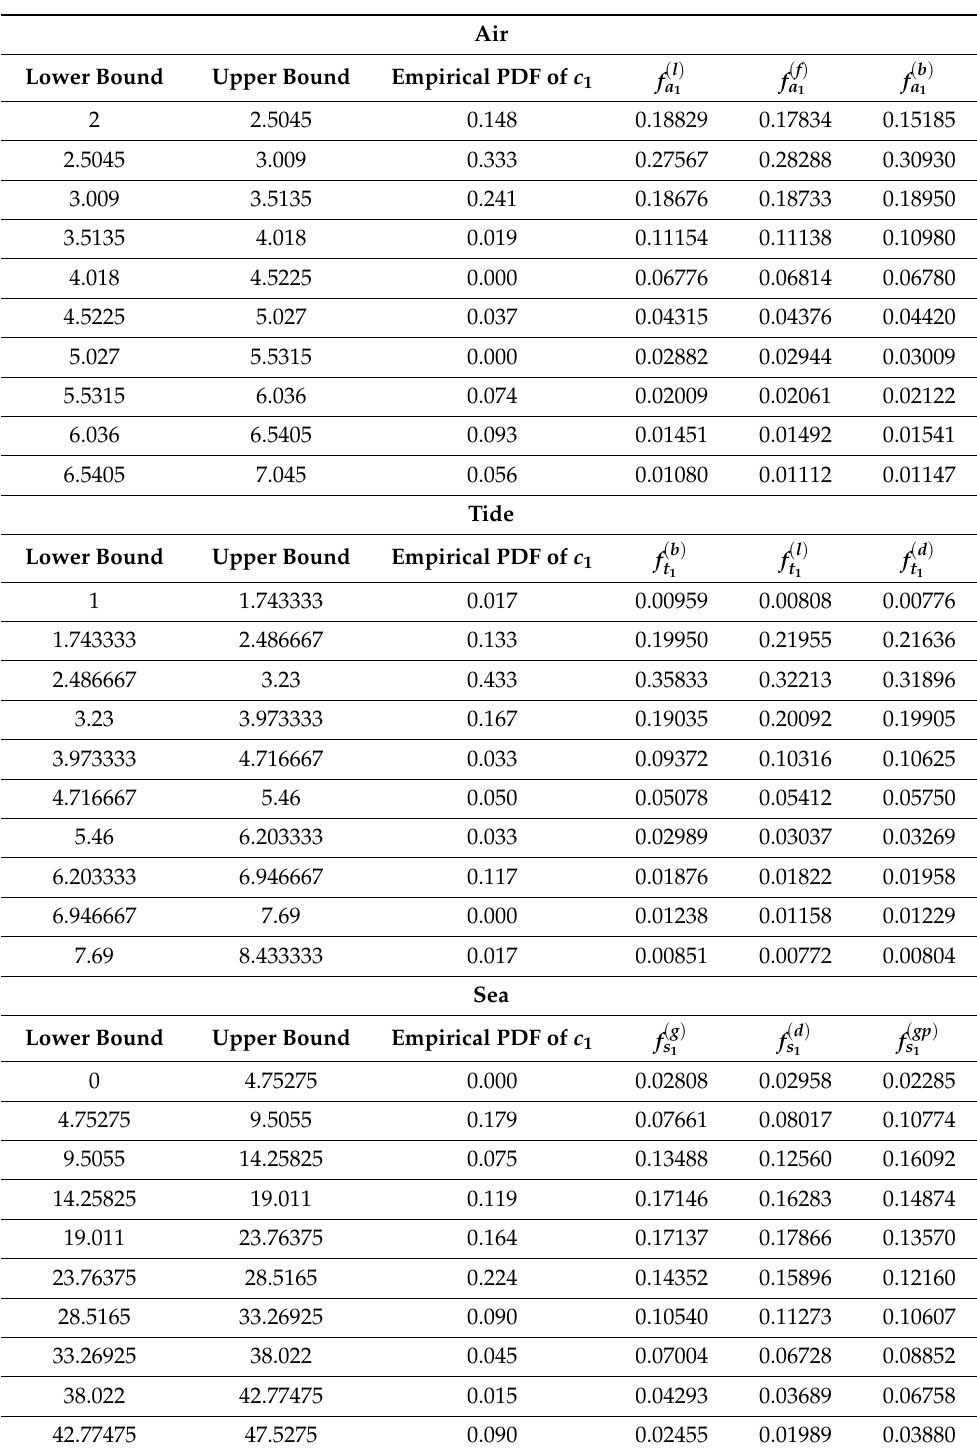
Table 9. The empirical values and the values of PDF for the three best-fitted distributions for c 1 concerning